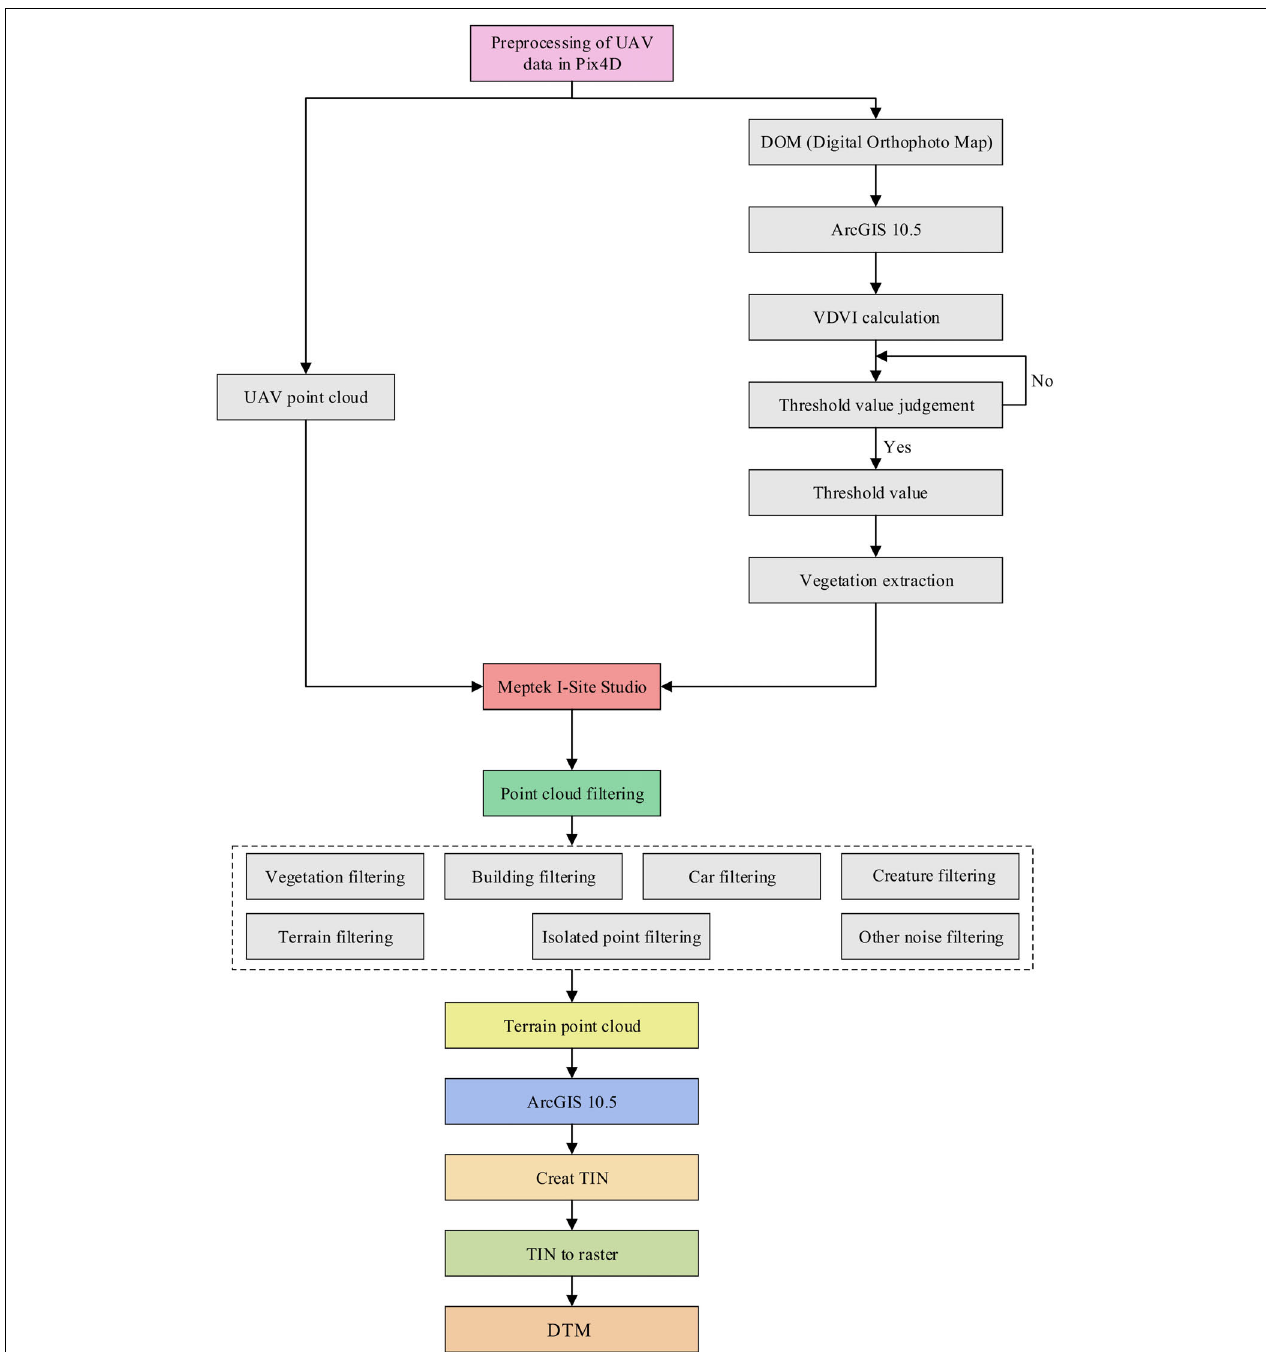
FIGURE 8 | Framework of UAV data